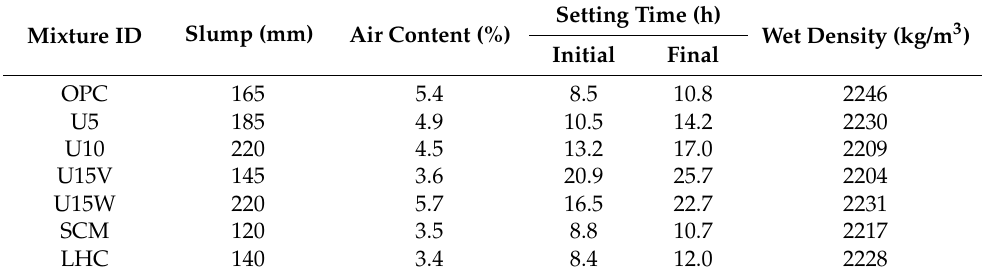
Table 4. Test results of fresh